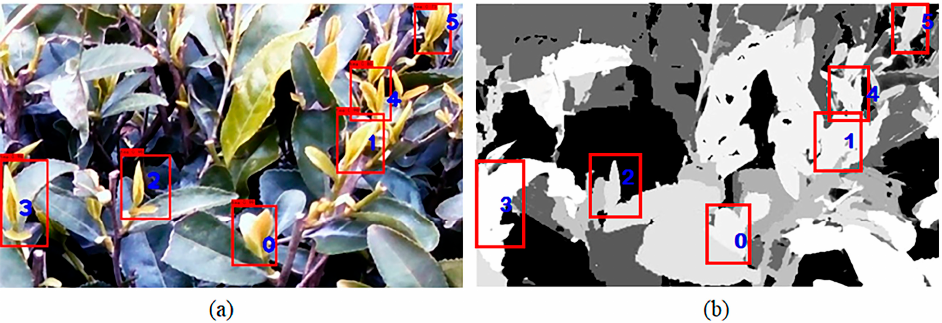
Figure 12. ( a ) Detected and localized tea buds in a color image, and ( b ) its depth image.